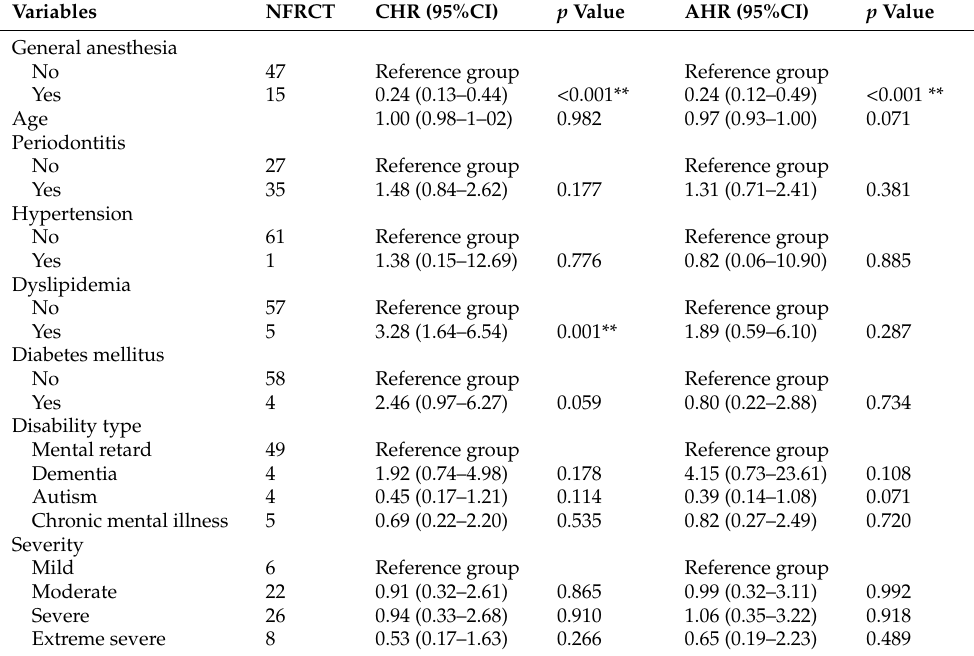
Table 3. Hazard ratio of failure of RCT in association with general anesthesia and other characteristics of patients or